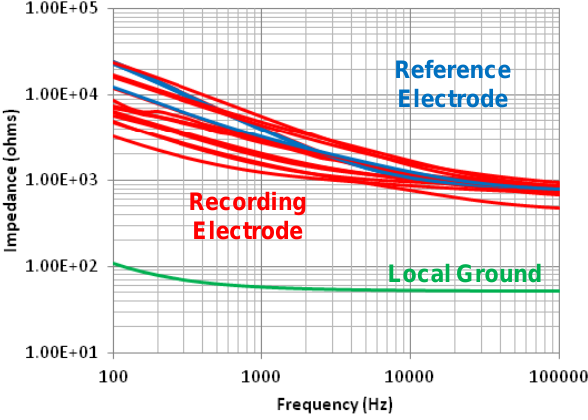
Figure 21. Measured impedance of the flexible microelectrode array.